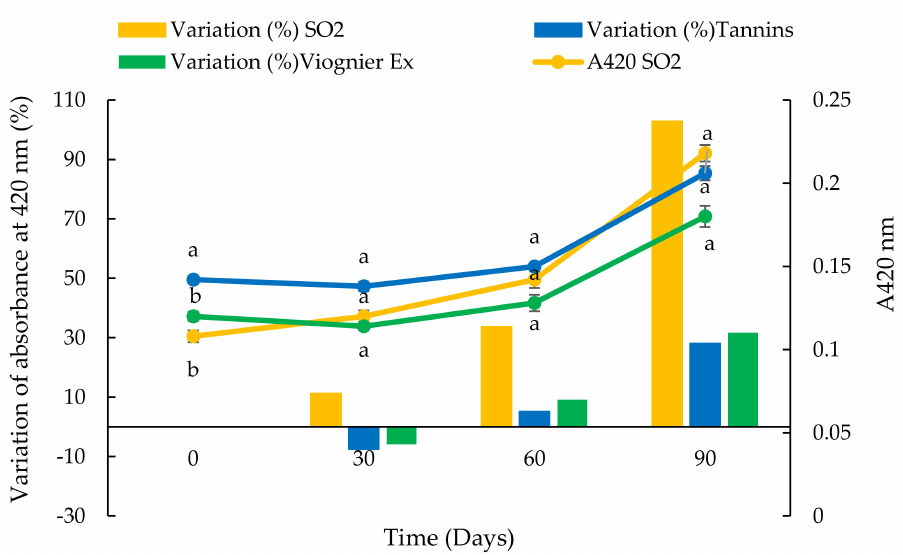
Figure 10. Evolution of absorbance at 420 nm and variation percentage of absorbance at 420 nm of a white wine over 90 days in stainless steel tanks after the addition of SO 2 , commercial tannins and Viognier UG extract. Values are the mean ± SD ( n = 2). Bars represent standard error. Different letters indicate significantly different values among the samples ( p < 0.001).